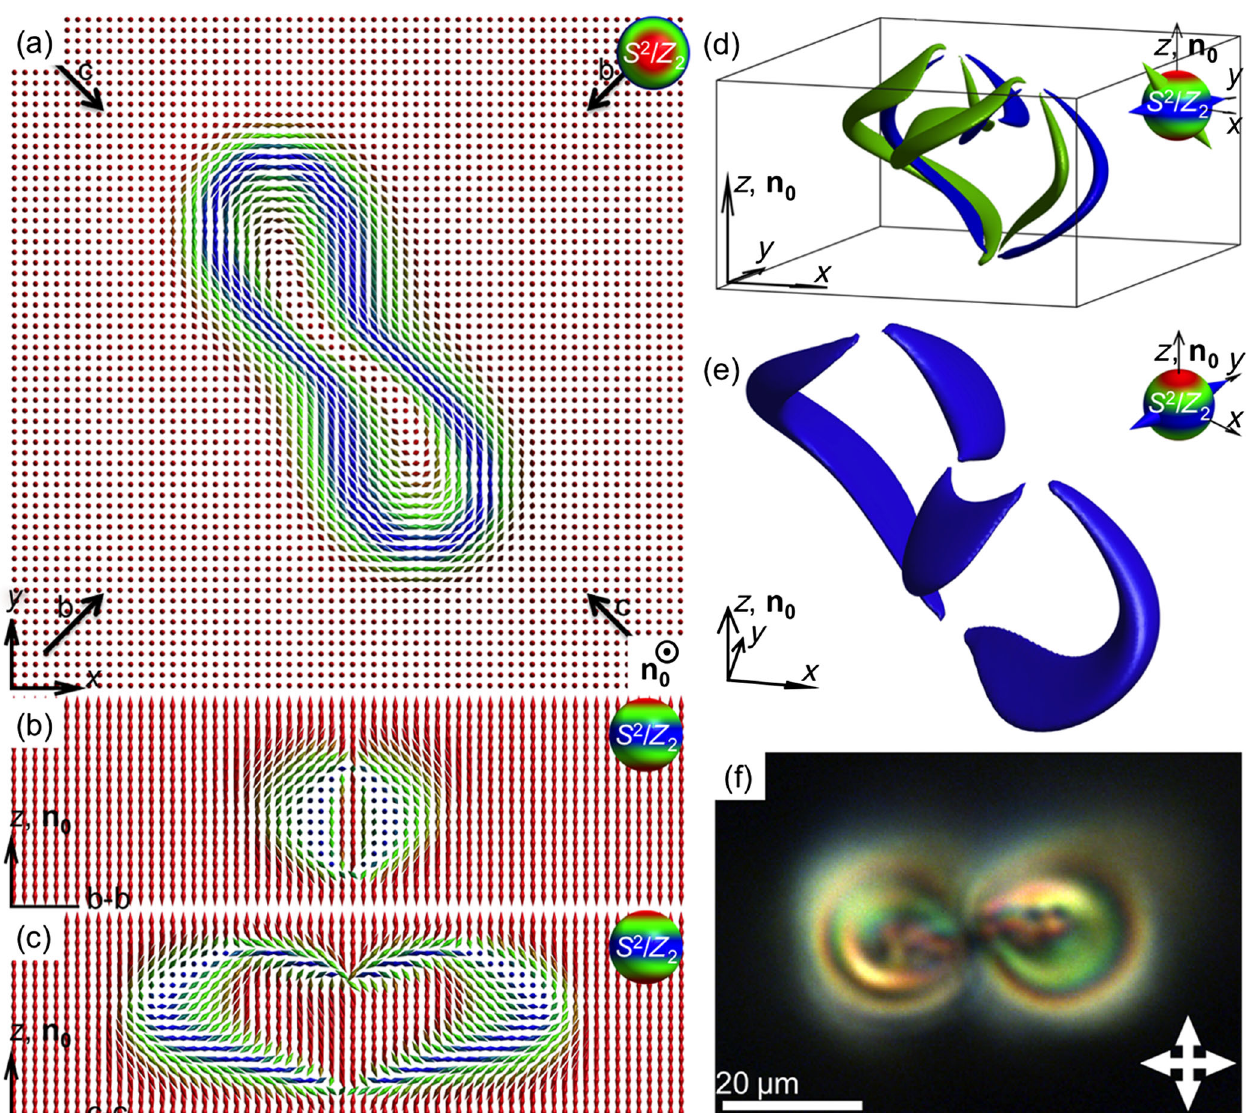
FIG. 13. A twistion structure in a chiral nematic LC. (a) – (c) Computer-simulated (a) in-plane and (b),(c) vertical cross sections of the 3D n ð r Þ structure of the twistion depicted using double cones and the color scheme that establishes correspondence between director orientations and the points on S 2 =Z 2 (top right insets). The locations of vertical cross sections (b) and (c) are depicted in (a) using arrows. (d) Computer-simulated preimages of the twistion for two sets of the diametrically opposite points on S 2 =Z 2 marked by double cones in the top right inset. (e) Computer-simulated preimages of the twistion for points on the “ equator ” of S 2 =Z 2 (top right inset). Computer simulations are performed for elastic constants of 5CB and d=p ¼ 0 . 85 . (f) A polarizing optical micrograph of the twistion, with the white double arrows showing crossed polarizers. The polarizing micrograph is obtained for a structure in a 5CB-based partially polymerizable nematic mixture doped with a chiral additive CB-15 in a cell with d=p ∼ 1